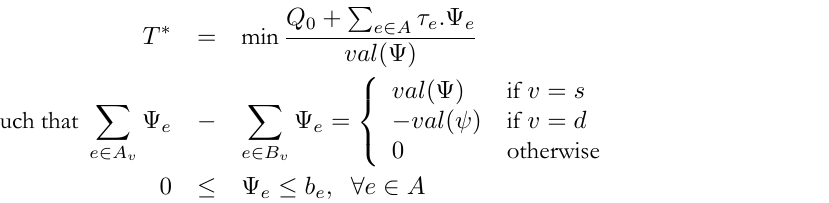
Algorithm 1 The s - d quickest evacuation